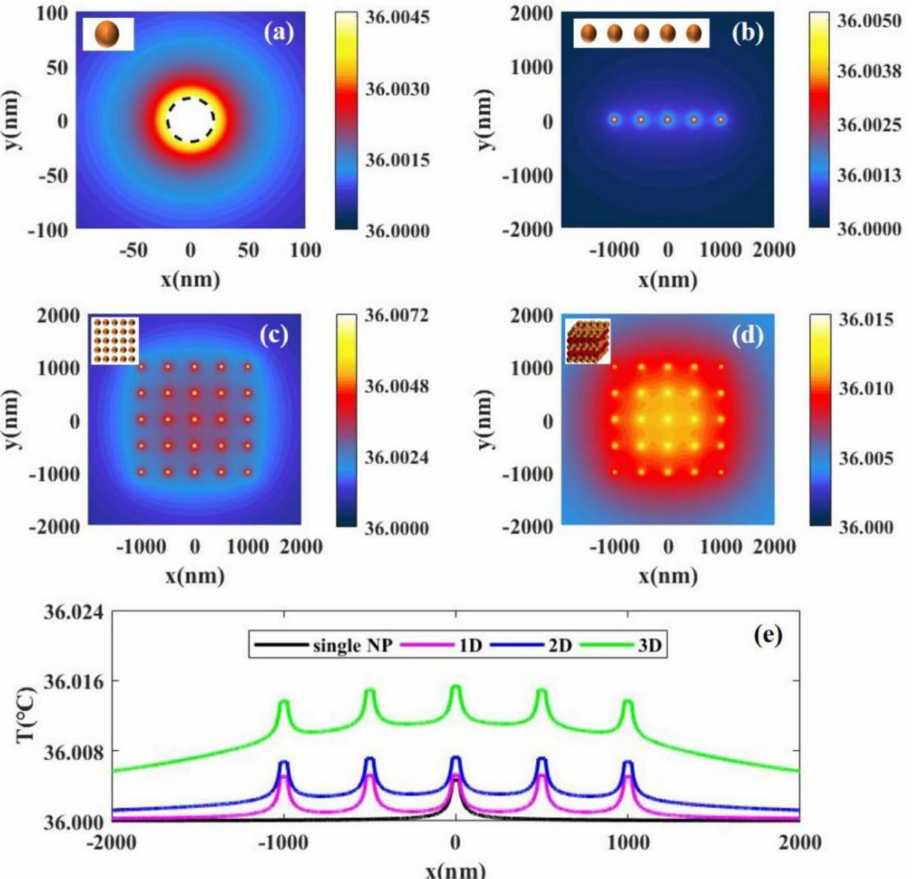
Figure 2. The temperature distributions with laser intensity I = 15 W/cm 2 caused by the photothermal conversion of ( a ) a single nanoparticle, ( b ) 5 nanoparticles uniformly distributed along the x axis, ( c ) 5 × 5 nanoparticles uniformly distributed in the x–y 2D plane, and ( d ) 5 × 5 × 5 nanoparticles uniformly distributed the in x-y-z 3D space. ( e ) A comparison of the temperature distributions caused by the photothermal conversion of single and multiple particles. The distance between the nearest particles is 500